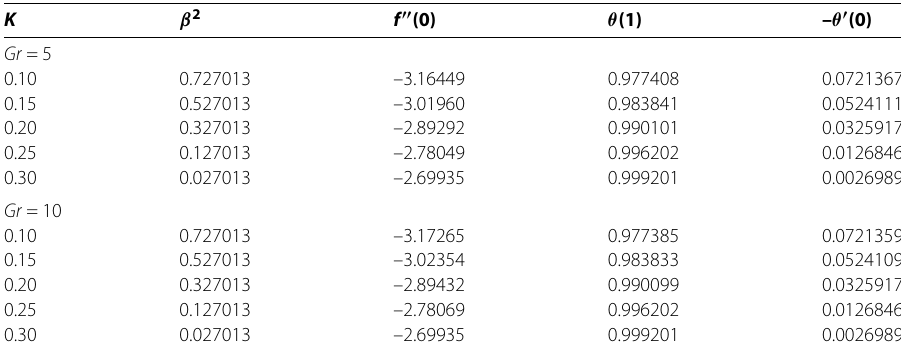
Table 5 Variation of β 2 = ϒ , f (cid:2)(cid:2) (0), θ (1) and – θ (cid:2) (0) using 20th-order HAM via Mathematica